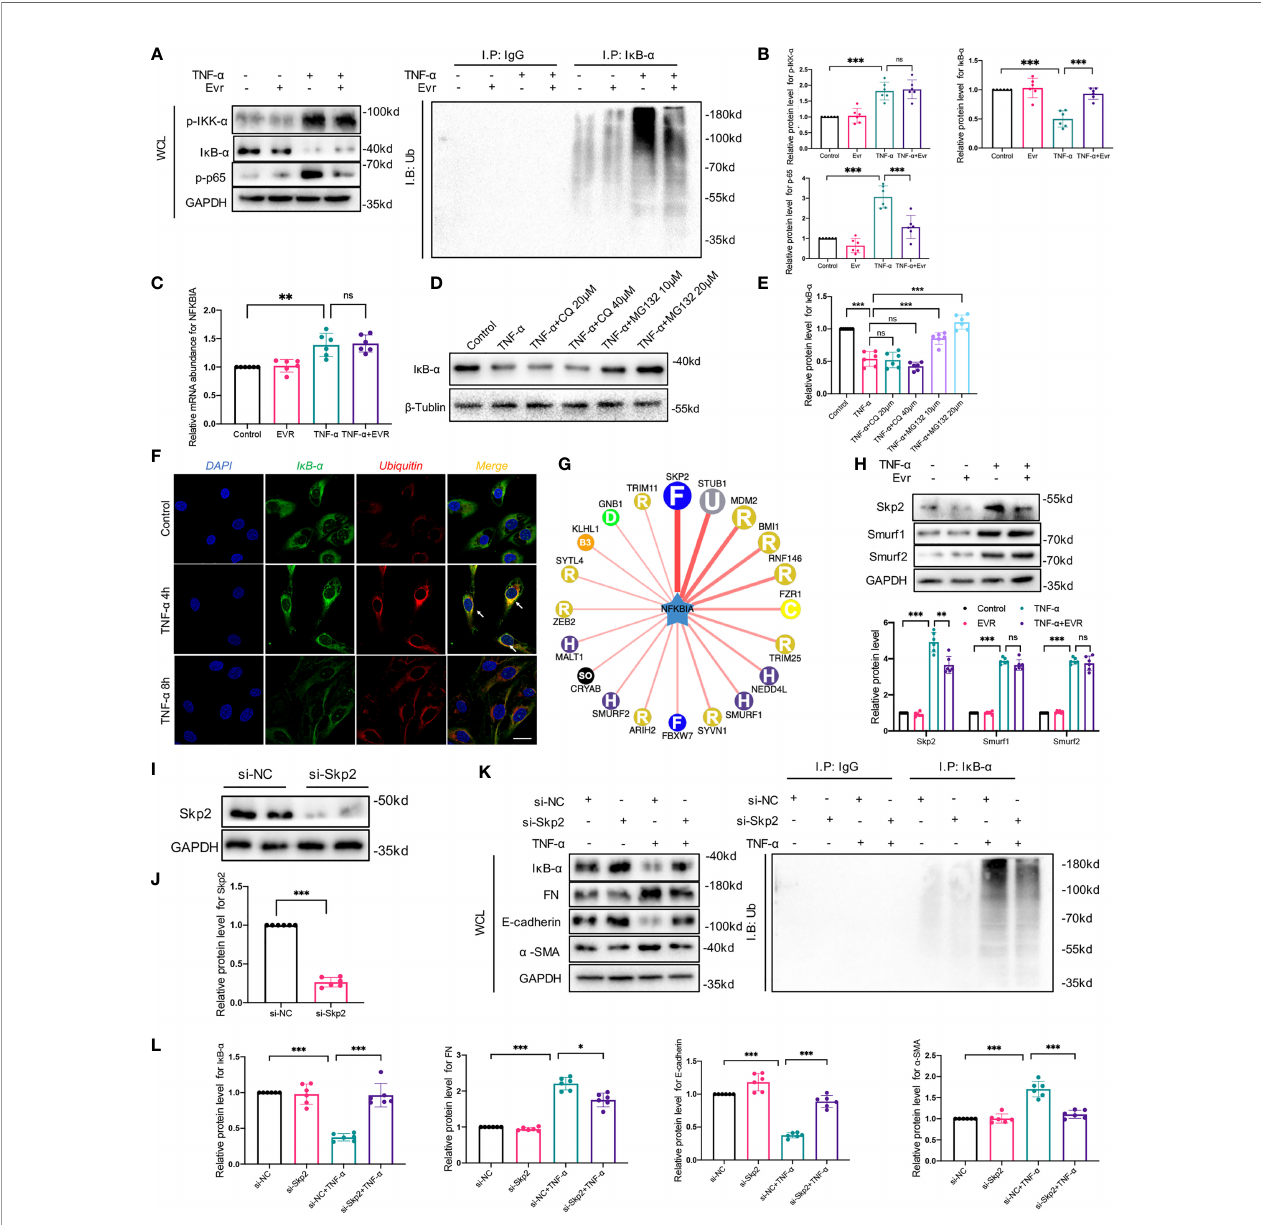
FIGURE 7 | EVR inhibited TNF- a -induced EMT by inhibiting degradation of I k B- a in HK-2 cells, and Skp2 played an essential role in this process. (A) Representative Western blotting results f p-IKK- a , IKK- a , I k B- a , p-p65, and p65 in WCL of HK-2 cells treated with TNF- a (50 ng/ml) and/or EVR (10 nM) for 24 h. In addition, immunoprecipitation was performed with a I k B- a antibody, and Western blot assays were used to examine the ubiquitin conjugation among the indicated groups. (B) Semi-quantitative analyses results of relative protein abundances of p-IKK- a , IKK- a , I k B- a , p-p65, and p65 in WCL of HK-2 cells treated with TNF- a and/or EVR for 24 h. Values represented the mean ± SD ( n = 6, ns, not signi fi cant, *** p < 0.001). (C) Relative expression of the NFKBIA in HK-2 cells treated with TNF- a (50 ng/ml) and/or EVR (10 nM) for 24 h. Values represented the mean ± SD ( n = 6, ns, not signi fi cant, ** p < 0.01). (D) Representative Western blotting results of I k B- a in HK2 cells treated with TNF- a (50 ng/ml) and different concentrations of CQ (20 and 40 m M)/MG132 (10 and 20 m M) for 24 h. (E) Semi-quantitative analyses results of relative protein abundance of I k B- a in HK-2 cells treated with TNF- a and CQ/MG132 for 24 h. Values represented the mean ± SD ( n = 6, ns, not signi fi cant, *** p < 0.001). (F) Representative IF co-localization staining images of I k B- a and ubiquitin in HK-2 cells treated with TNF- a for 4 or 8 h (scale bar: 50 m m). (G) The network map of E3 ubiquitin ligase related to I k B- a predicted by UbiBrowser. (H) Representative Western blotting results of Skp2, Smurf1, and Smurf2 in HK2 cells treated with TNF- a (50 ng/ml) and/or EVR (10 nM) for 24 h. (I, J) Representative Western blotting results of negative control (NC) and small interfering RNA (si-Skp2) transfection ef fi ciency in HK2 cells. (K, L) Representative Western blotting results of I k B- a , E-cadherin, a -SMA and FN in WCL of HK-2 cells treated with TNF- a (50 ng/ml) after transfecting si-Skp2 or si-NC. Immunoprecipitation was also performed with an I k B- a antibody, and Western blot assays were used to examine the ubiquitin conjugation among the indicated groups. Values represented the mean ± SD ( n = 6, * p < 0.05, *** p < 0.001). WCL, whole-cell lysates; IF, immuno fl uorescence; EVR, everolimus; CQ, chloroquine; a -SMA, a -smooth muscle actin; FN, fi